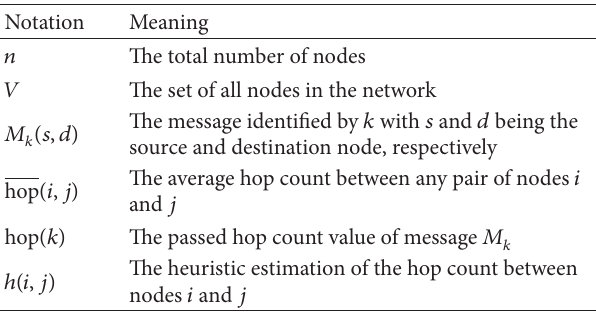
Table 1: Mathematical